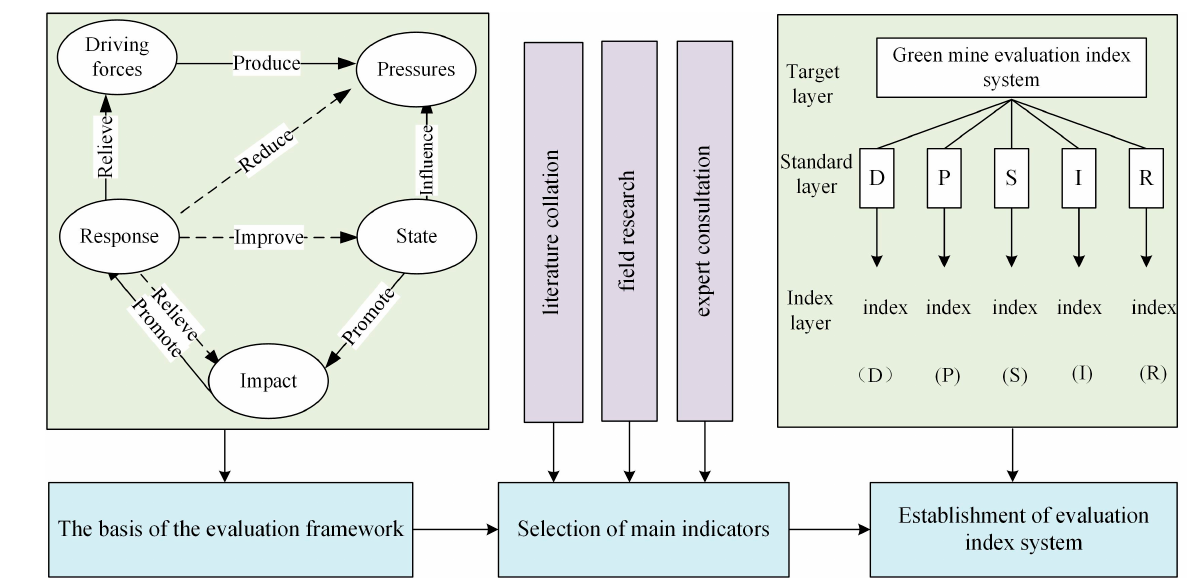
Figure 1. Green Mine Construction Evaluation System Based on DPSIR Framework.